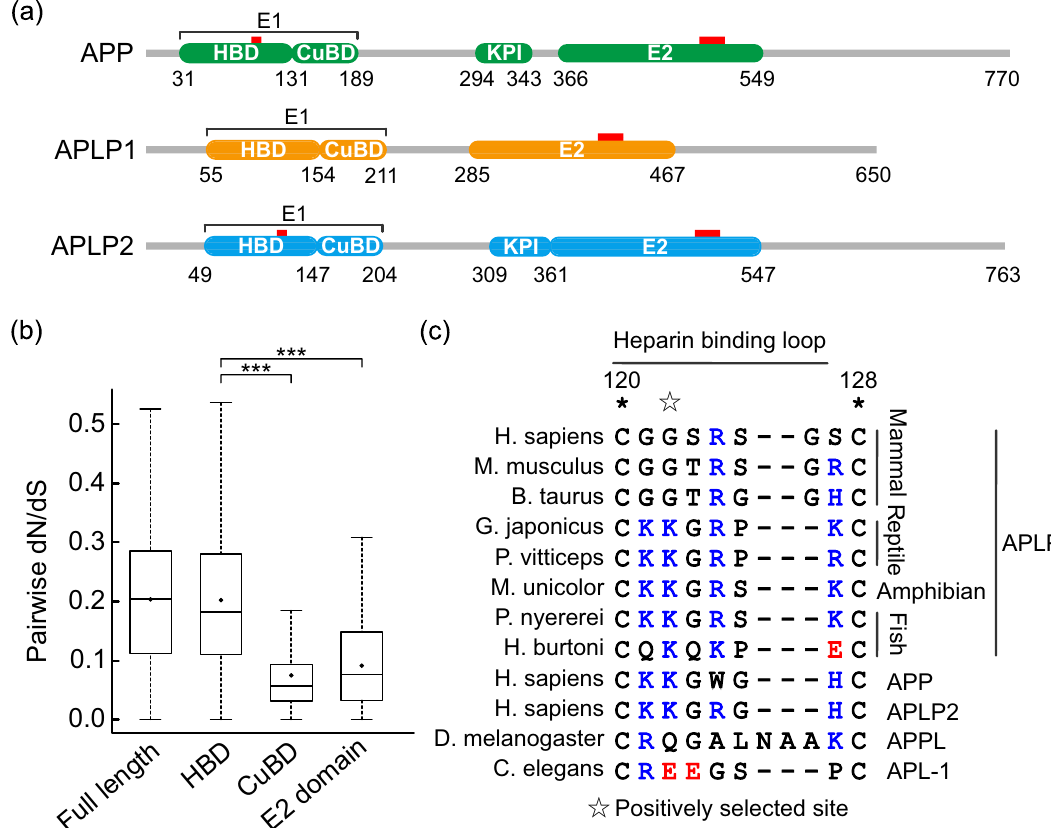
Figure 3. Positive selection of the heparin-binding domain of the mammalian APLP1. ( a ) The domain structure of the human APP family; heparin-binding domain (HBD); copper-binding domain (CuBD); Kunitz-type protease-inhibitor domain (KPI). Heparin binding sites are labeled with red line. ( b ) Pairwise dN/ dS analysis of domains in the vertebrate APLP1. Dots show means of each dN/dS. HBD showed a significant increase in dN/dS. (***P-value < 0.01). ( c ) The positively selected sites for the stem branch of mammalian APLP1 detected by the branch-site model of dN/dS estimation. A site on the heparin-binding loop was selected, where the mammalian APLP1 has a glycine, while other sequences have positively charged residues (colored in